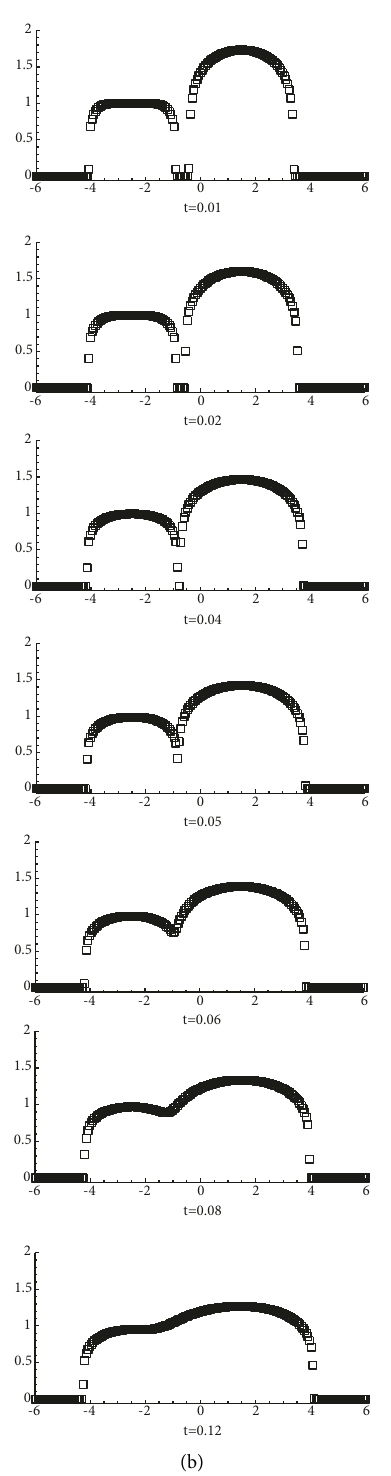
Figure 2: Example 4. Collision of two-box solution for PME. CRUS-WENO scheme (a), WENO-JS scheme